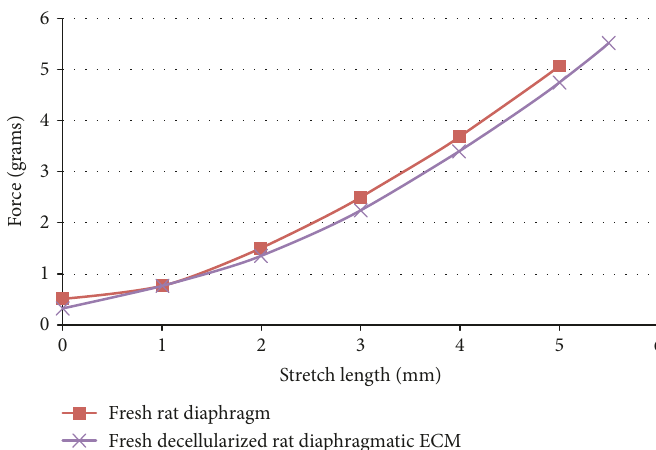
Figure 7: Modeling testing for the decellularized ECM sca ff olds in vitro. Within the maximum stretch distance of 6.0mm and maximum force of 6.0 grams applied to the ECM sca ff olds, the results showed the similarity of stress/strain between the fresh rat diaphragms and the decellularized ECM sca ff olds of rat